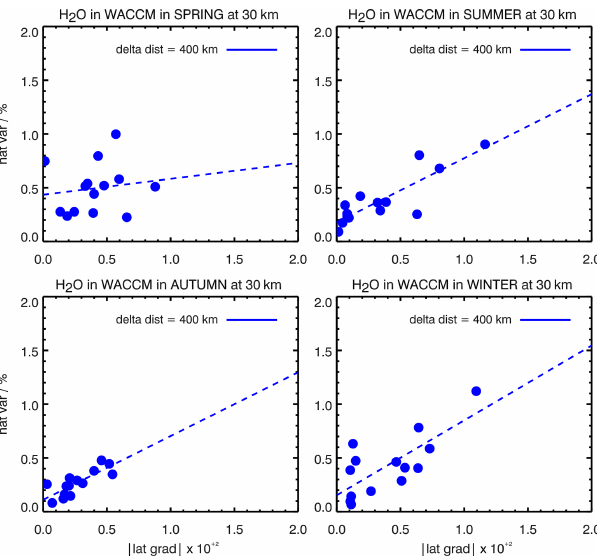
Figure 6. Natural variability of H 2 O as a function of latitudinal gradients for a 400km distance separation at 30km altitude in four seasons in the WACCM model. The horizontal axis corresponds to latitudinal gradients, and the dashed line is the linear regression of plotted points.